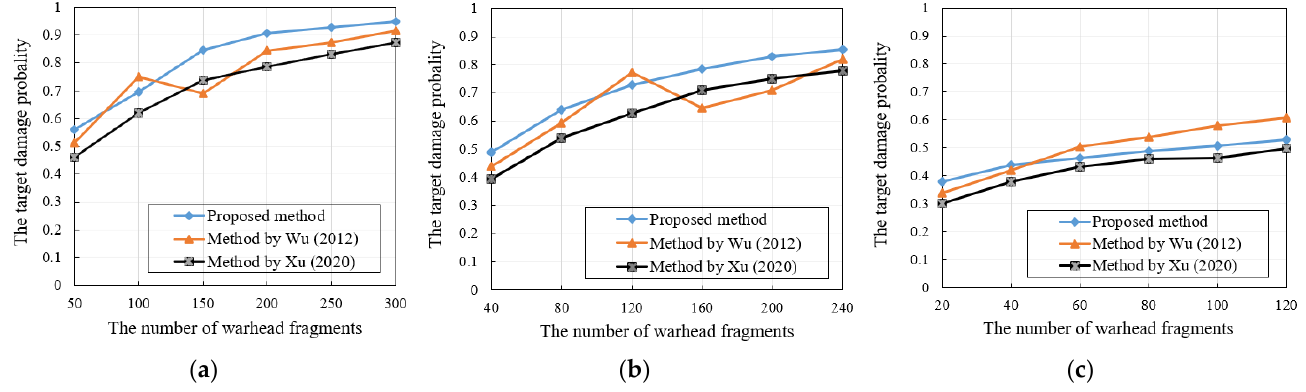
Figure 7. The change curve of the target damage probability under different intersection angles: ( a ) The damage gain of the confrontation game when the intersection angle of the projectile and the aircraft target is 30°; ( b ) The damage gain of the confrontation game when the intersection angle of the projectile and the aircraft target is 45°; ( c ) The damage gain of the confrontation game when the intersection angle of the projectile and the aircraft target is 60° [3,7].